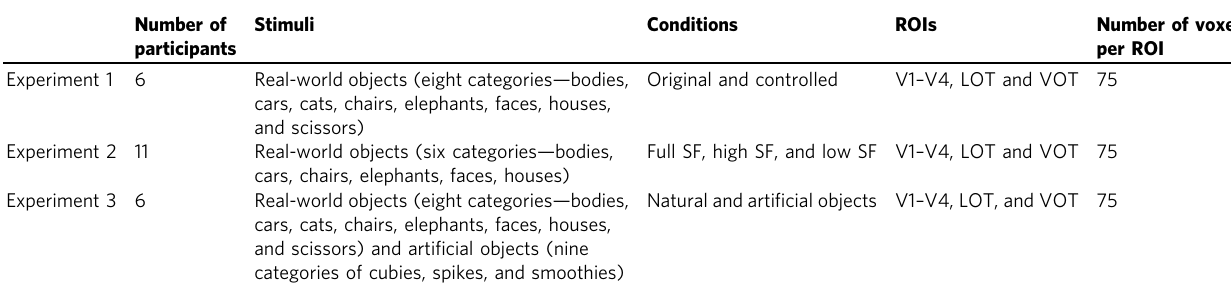
Table 1 A summary of the experimental